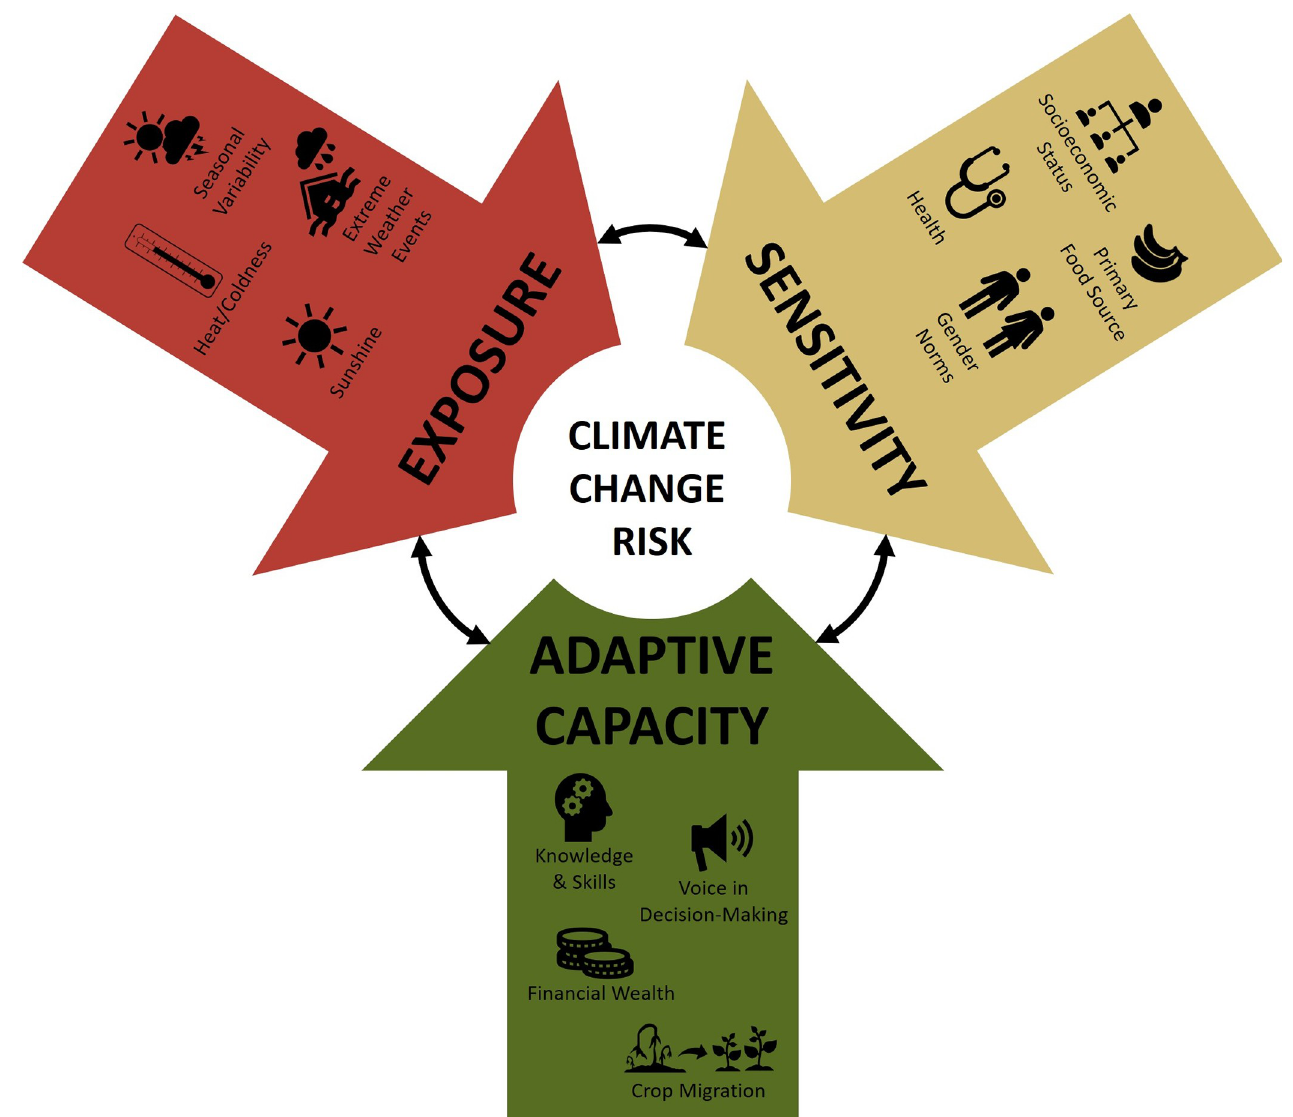
Fig 1. Conceptual framework highlighting factors affecting climate change risk in rural